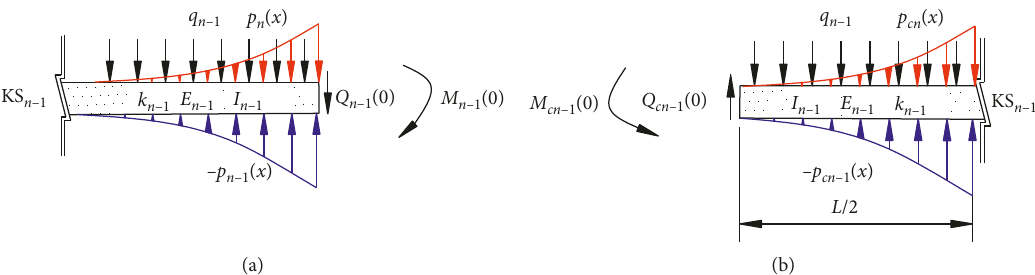
Figure 7: Stress analysis of the curve subsidence zone KS: (a) side of the coal mass; (b) side of the goaf.